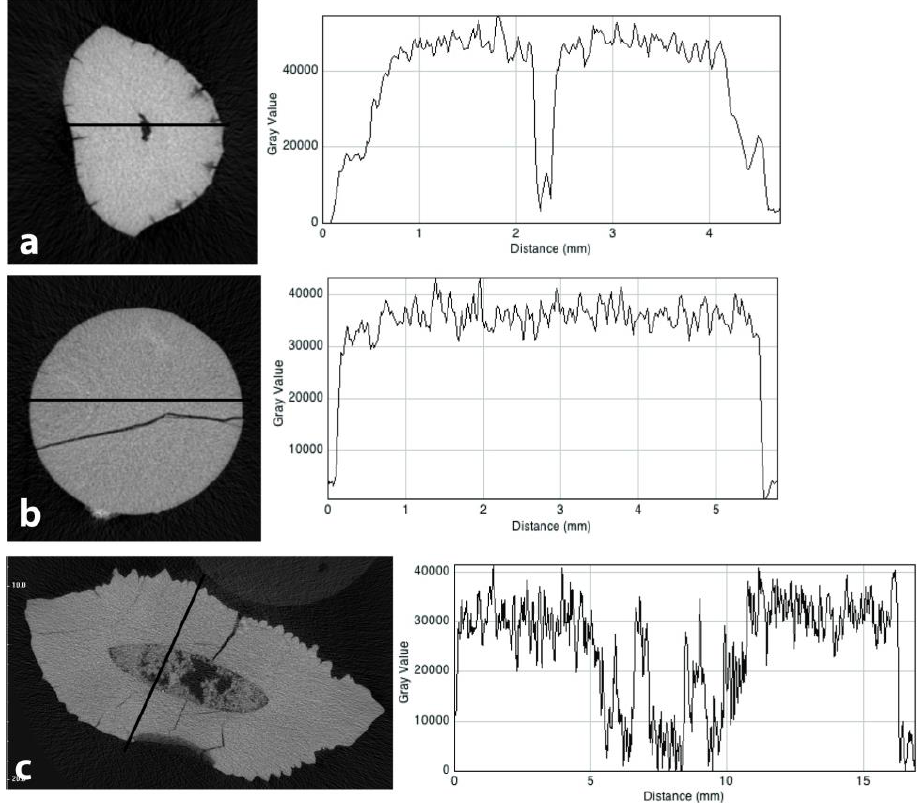
Fig. 7. Reconstructed Micro-CT cross-sections of fossil odontocete teeth and greyscale value/distance profile. Note the preservation artifacts (irregular dark lines) in b and c. a) Unnamed Squalodontidae sp.1 (OU 22457). b) Unnamed Delphinoidea sp.1 (SGO-PV-754). c) Unnamed Squalodontidae sp.2